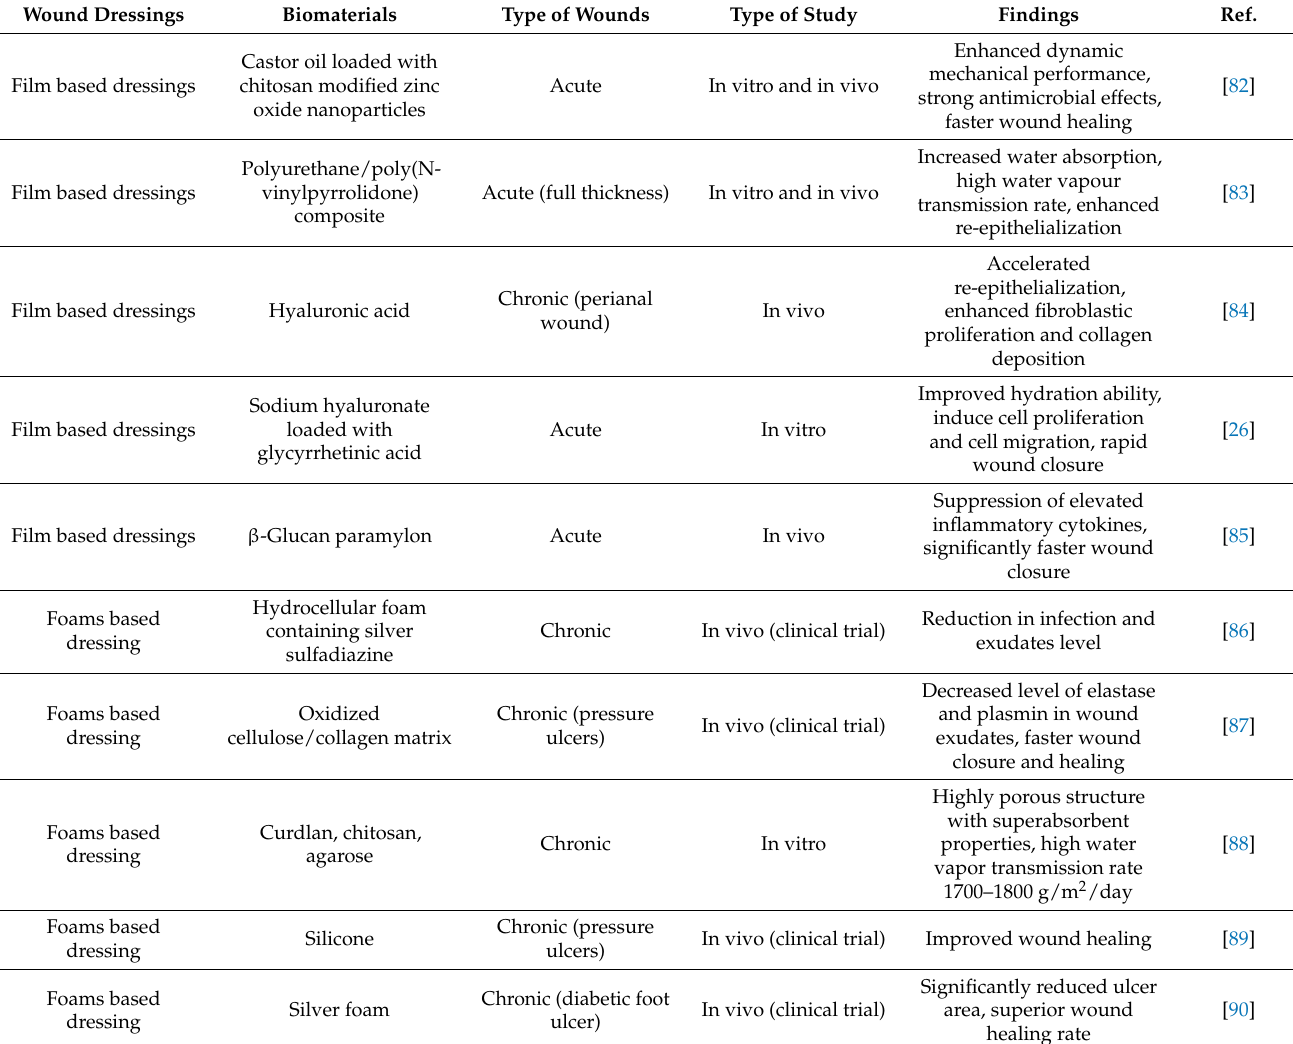
Table 1. A representative list of modern wound dressings for acute and chronic wounds healing. Type of Wounds Type of Study Findings